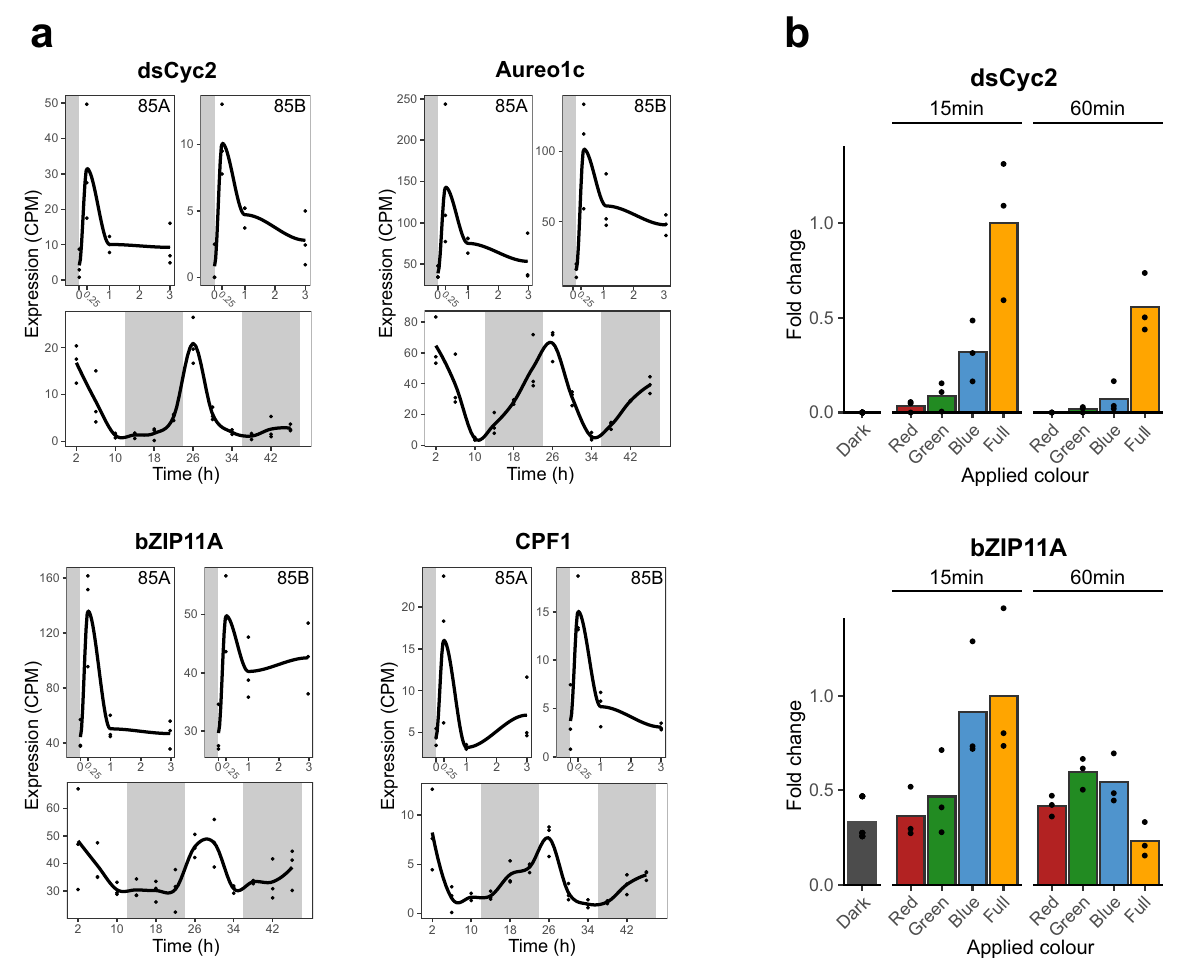
Figure 5. Expression of putative light-dependent G1 checkpoint genes in Seminavis robusta. ( a) Expression over time (in h) in counts per million (CPM) of genes potentially downstream of the blue light photoreceptor Aureo1a : diatom-specific cyclin 2 ( dsCyc2 ), aureochrome 1c ( Aureo1c ), basic leucine zipper transcription factor bZIP11A and cryptochrome/photolyase family 1 ( CPF1 ). On top: transcriptome data representing the response to light after a prolonged dark arrest from Moeys et al. (2016) (strain 85B) 7 and Bilcke et al. (2021a) (strain 85A) 10 . Below: expression throughout a 2-day time series in a 12/12 day/night rhythm from Bilcke et al. (2021b) 62 . Grey shading represents dark conditions. ( b) RT-qPCR measurements of dsCyc2 and bZIP11A expression in darkness (“Dark”) and after treatment with light spectra for different durations (15 min, 60 min). The Lee colour filters used for these treatments were Primary Green (#139), Blood Red (#789) and Special Medium Blue (#363). Relative expression is given as fold changes compared to the average expression of full spectrum light control after 15 min of illumination. Individual data points are shown as dots, while bar plots represent the average fold change for each The Aureo1a1 homolog was even significantly downregulated by 15 min of light in both strains (Supplementary Table S3), a response that has also been observed in P. tricornutum 59,63 . To verify blue light photoreceptor dependent expression of dsCyc2 and bZIP11A , we quantified their expres- sion with real-time quantitative PCR (RT-qPCR) over the course of a time series of 0 h (darkness), 15 min and 60 min, during which cultures were exposed to red, blue, green and full spectrum light. Fifteen minutes of white and blue light caused a significantly upregulation of both dsCyc2 and bZIP11A compared to darkness ( p < 0.05), while red and green light did not cause such an induction (Fig. 5b, Supplementary Fig. S7). The blue-light response of dsCyc2 was most pronounced, with expression being almost undetectable in darkness and in red light, while white and blue light induced a highly significant upregulation (Fig. 5b).